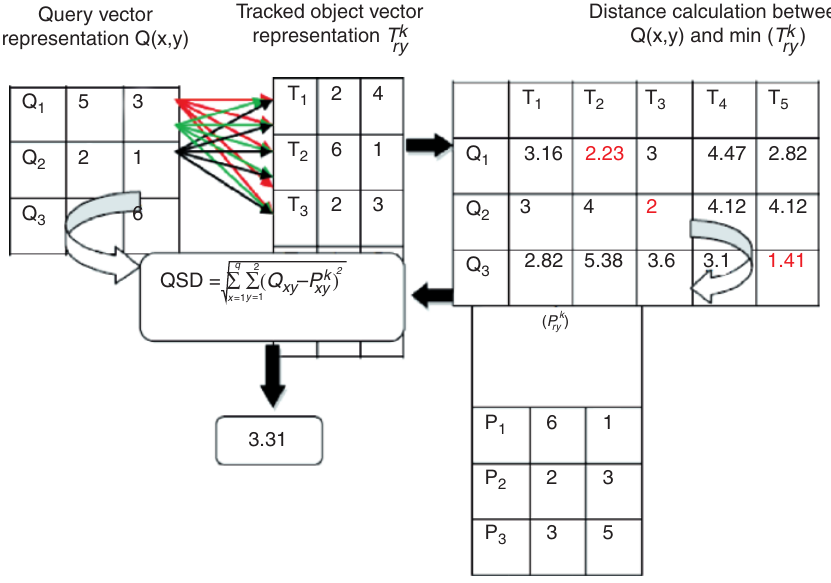
Figure 2: Example Calculation of QSD. object vector are represented in two dimensions, but the sizes of both representations are different, which is shown